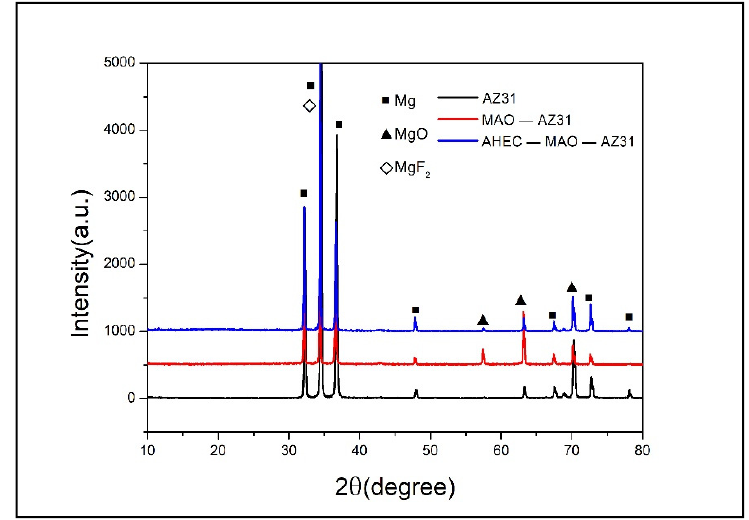
Figure 3. X-ray diffraction (XRD) pattern of AZ31, MAO + AZ31, and AHEC + MAO + AZ31 specimens.